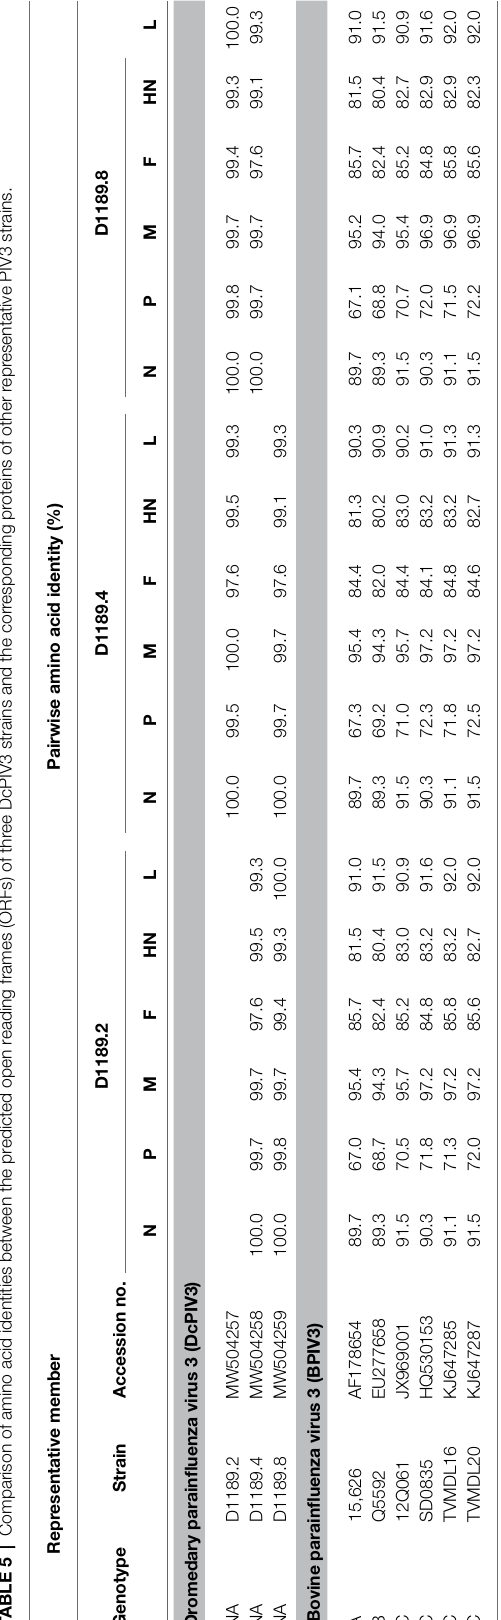
TABLE 4 | Comparison of amino acid substitutions among the three DcPIV3 isolates in this study.